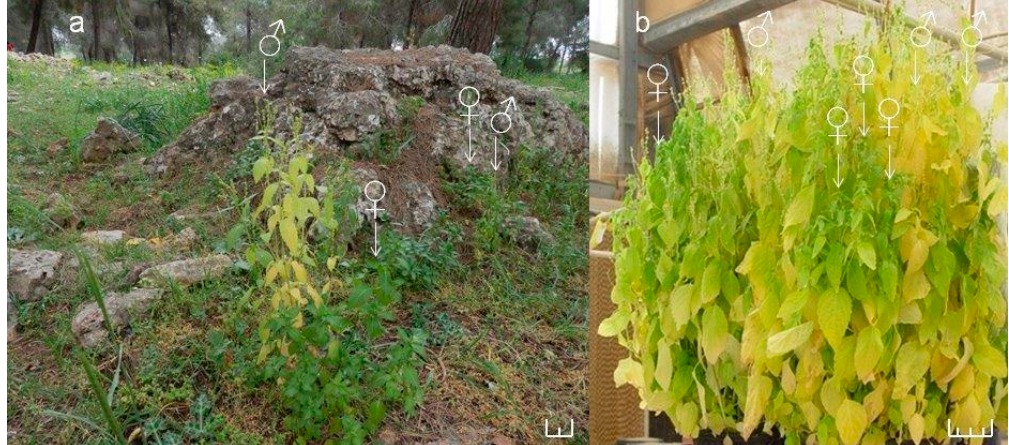
Figure 1. Mercurialis annua female and male plants in nature and controlled conditions. Plants in nature in the Lower Galilee (32°43 ′ 08 ′′ N 35°23 ′ 38 ′′ E) (a) and grown densely under controlled conditions at ‘late senescence’ stage (b). Female M. annua plants bear sub-sessile flowers, being borne on short pedicels in the leaf axils. Male plants are morphologically distinct, with flowers on longpedunculated inflorescences. The scale bar represents 5 cm.